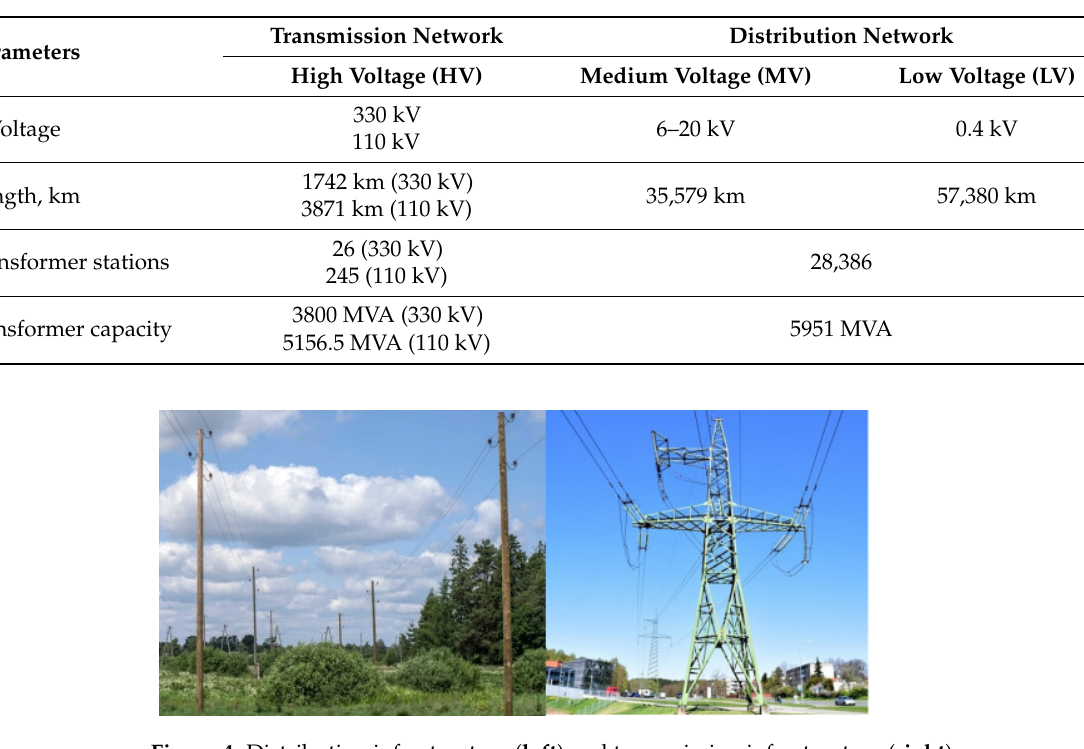
Table 1. Latvian electric power system details.